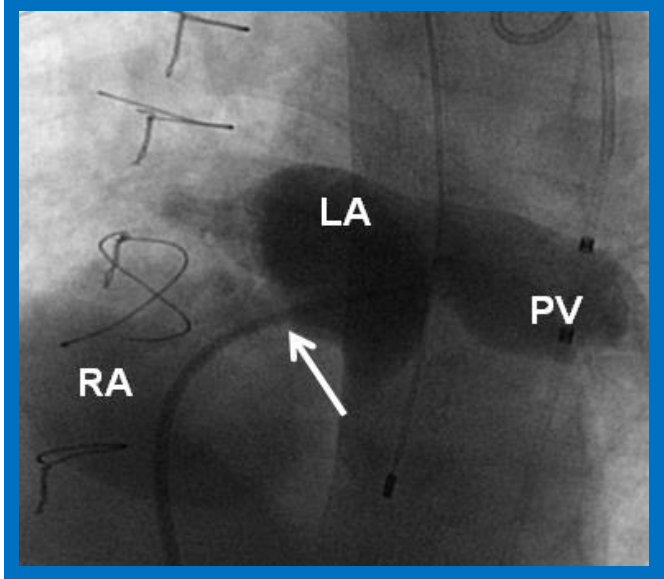
Figure 5. A selected cine frame from a cine-angiogram of the left atrium (LA) illustrates the position of the restricted atrial septum (arrow) and a markedly dilated pulmonary vein (PV). Sternal wires from prior surgery are seen, but not labeled. RA, right atrium. Modified from [7].